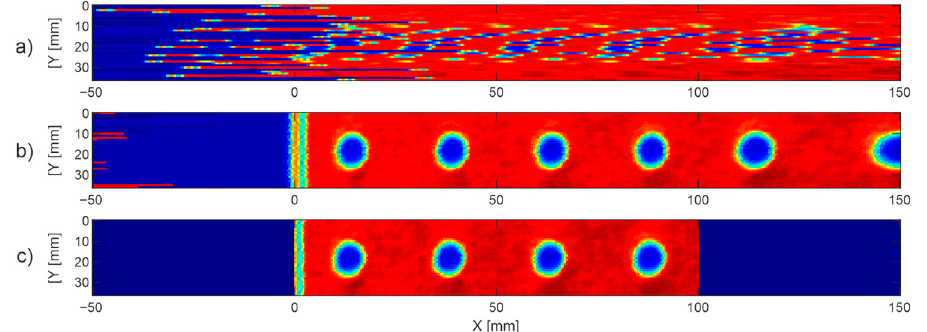
Figure 6. Line shifting algorithm. C-scan of randomly shifted lines ( a ), lines shifted to 0 point ( b ), and resultant image ( c ).